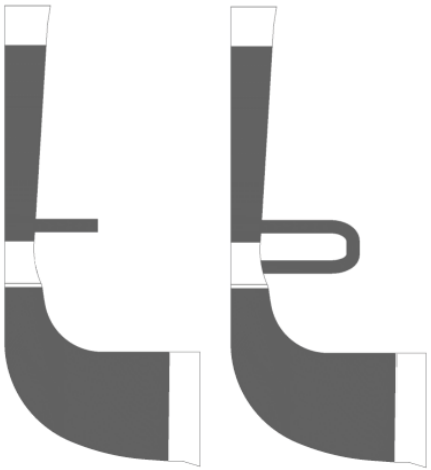
Figure 26: Air bleeding and air recirculation